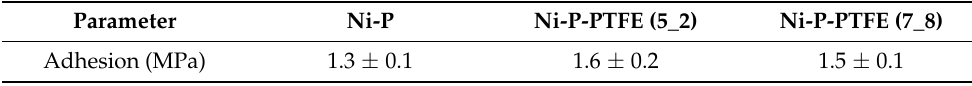
Table 2. Adhesion of the Ni-P and Ni-PTFE films measured by the DPO method. Parameter